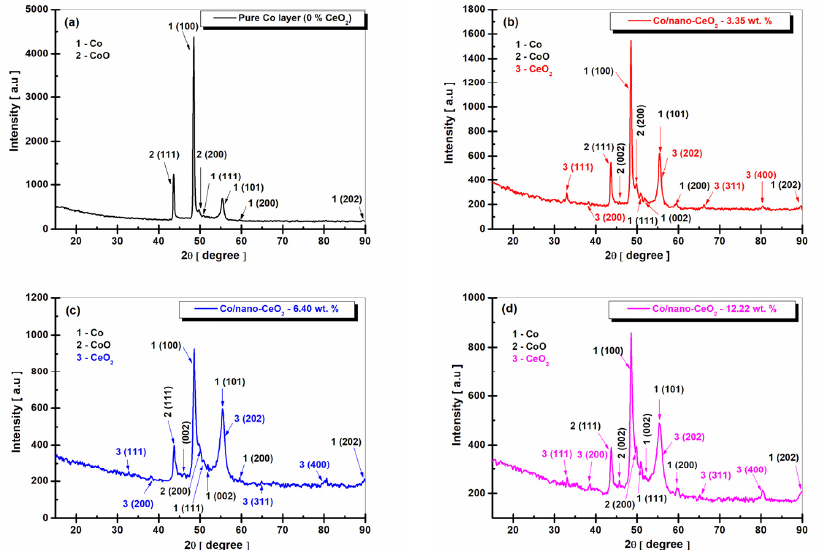
Figure 5. XRD patterns of electrodeposited layers obtained at a current density of 72 mA cm − 2 : ( a ) pure Co layer (0 wt. % CeO 2 ), ( b ) Co/nano-CeO 2 —10 g/L layer (3.35 wt. % CeO 2 ), ( c ) Co/nano-CeO 2 —20 g/L layer (6.40 wt. % CeO 2 ), and ( d ) Co/nano-CeO 2 —30 g/L layer (12.22 wt. % CeO 2 ).